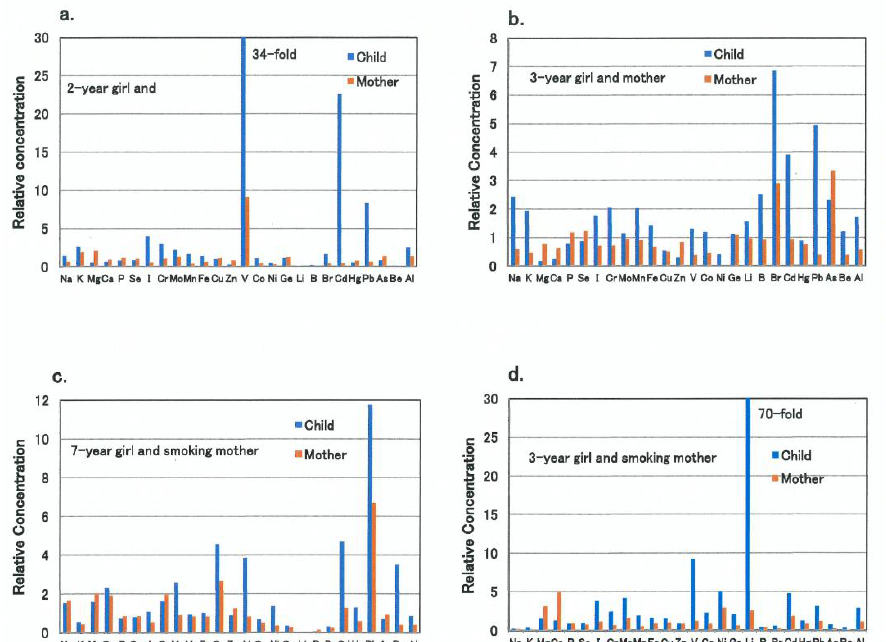
Figure 3. Metallome profiles of four child/mother pairs with some toxic metal burdens and/or essential metal deficiency. Each bar (blue and red) represents the relative concentration of the respective trace element in child’s and the mother’s scalp hair specimens, respectively. The 1.0 of the relative concentration represents the reference control level of each trace element. ( a ) A typical metallome profile of a 2-year-old girl and her mother is shown, exhibiting severe zinc deficiency and simultaneous high burdens with vanadium, cadmium, and lead in the child. ( b ) Another typical metallome profile of a 3-year-old girl and her mother is shown, exhibiting severe magnesium deficiency and simultaneous burdens with lead, cadmium, and bromine in the child. ( c ) A typical metallome profile of a 7-year-old girl and her smoking mother is shown, exhibiting severe lead burden and simultaneous burdens with cadmium, copper, and vanadium in the child. ( d ) Another typical metallome profile of a 3-year-old girl and her smoking mother is shown, exhibiting sever lithium burden and simultaneous burdens with vanadium, nickel, and cadmium in the child.